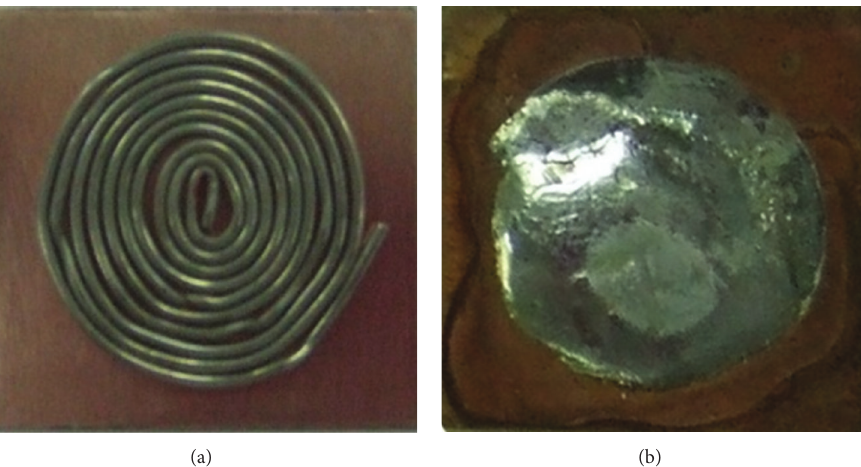
Figure 1: Appearance change of (a) a coiled SAC305 solder wire into (b) a solid SAC305 solder on the Cu substrate during solder reflowing.